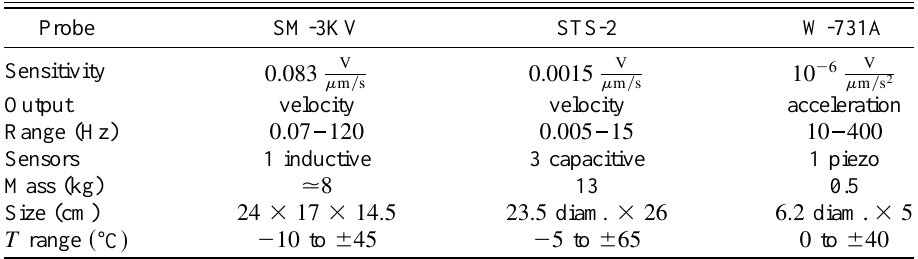
TABLE II. Seismic